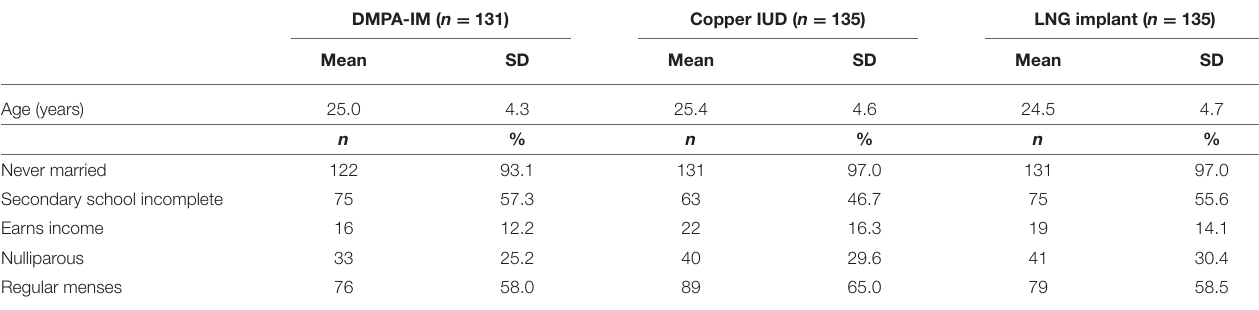
TABLE 1 | Baseline variables.